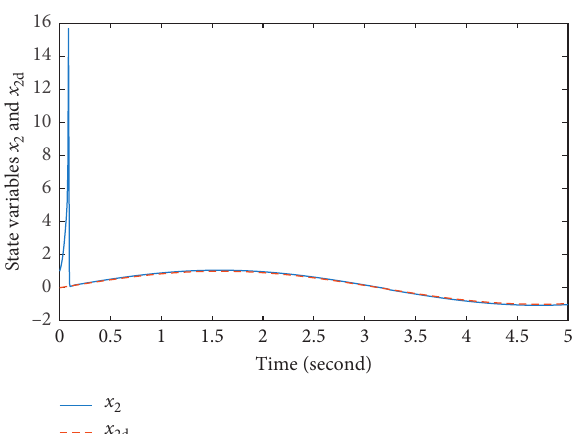
, e , and x with control scheme 1 2 3